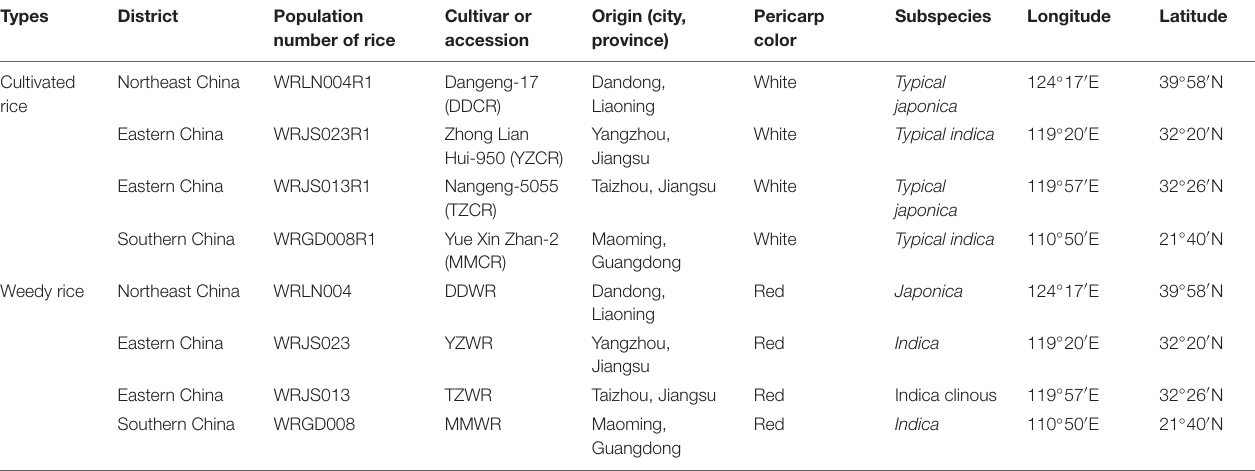
TABLE 1 | Characteristics of the representative weedy rice ( Oryza sativa L. f. spontanea ) and cultivated rice ( Oryza sativa L.) accessions used in the experiments.